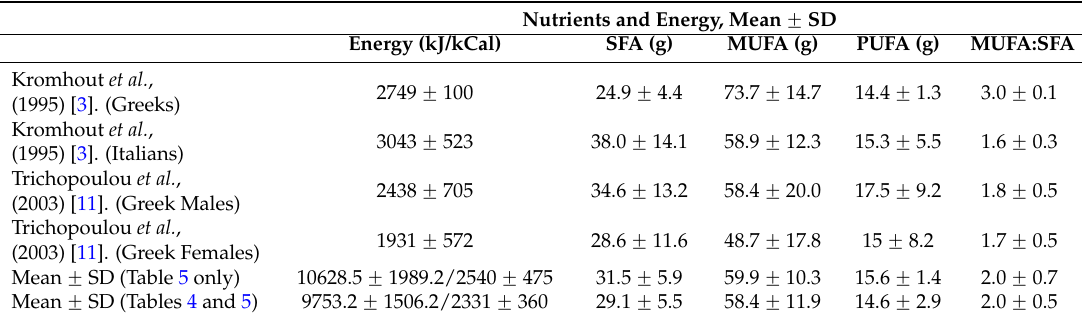
Table 5. Mean nutrient intake (grams per day) reported in the Seven Countries Study (Greek and Italian cohorts) and EPIC study (Greek cohort).